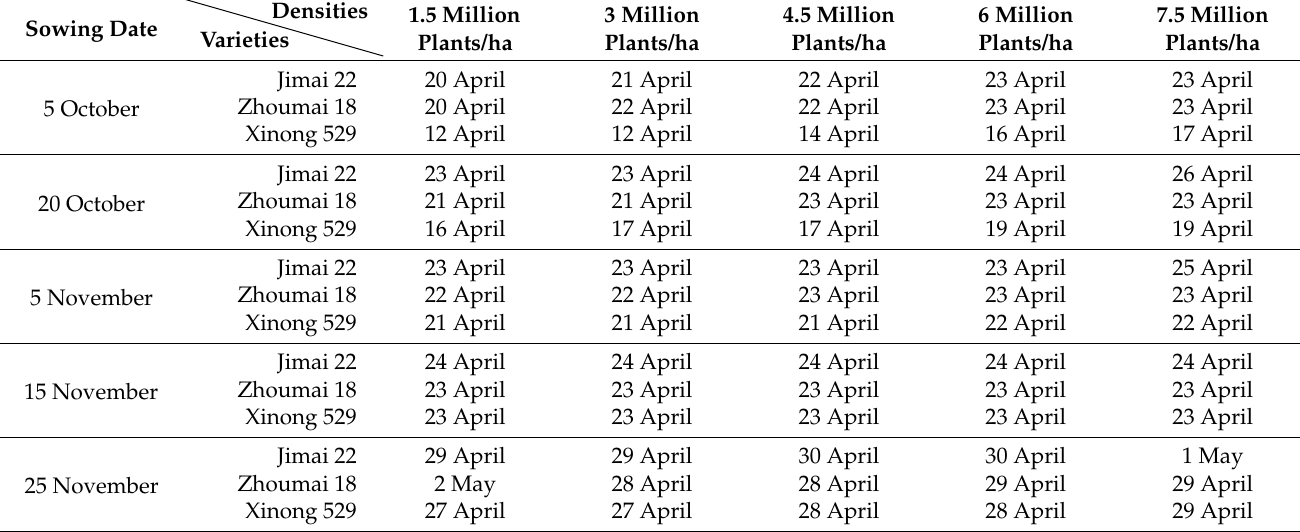
Figure 1. Study area and experimental design. ( a ) Location of the study area; ( b ) Orthomosaic; ( c ) Cultivation plots for each sowing date; ( d ) Magnified image of the orthomosaic; ( e ) Measurements of a ground control point. A total of 75 experimental wheat plots, observed from October 2018 to June 2019, were set up using three wheat varieties (Jimai 22, Zhoumai 18, and Xinong 529) sown on five different dates (5 October, 20 October, 5 November, 15 November, and 25 November) with five plant densities (1.5 million, 3 million, 4.5 million, 6 million, and 7.5 million plants/ha) (Figure 1, Table 1). The dimensions of one plot are about 1.15 m × 9 m (10.35 m 2 ). Table 1. Plot designs for field experiments and heading date